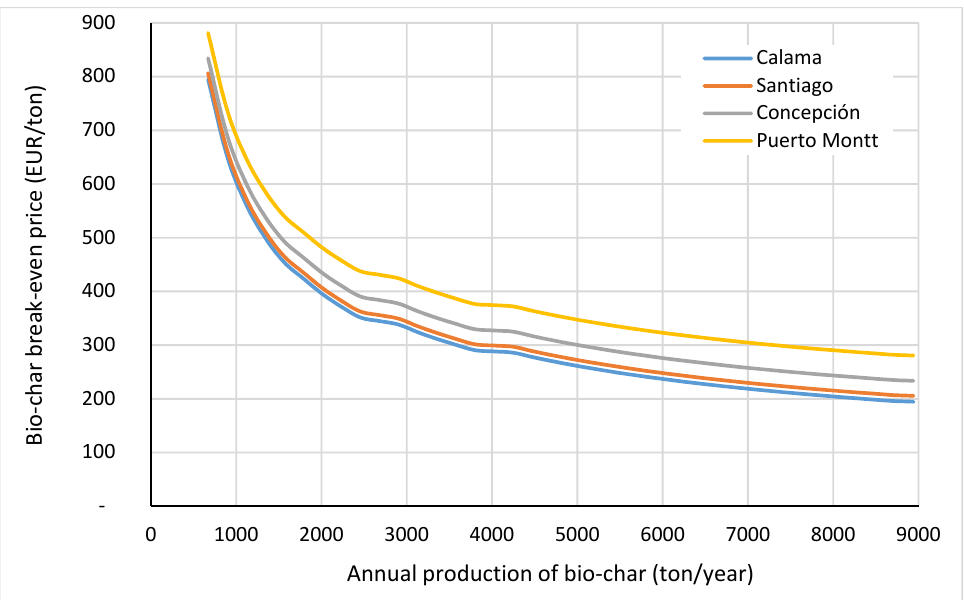
Figure 4. Economies of scale of bio-char production via pyrolysis in the Bío-Bío region.